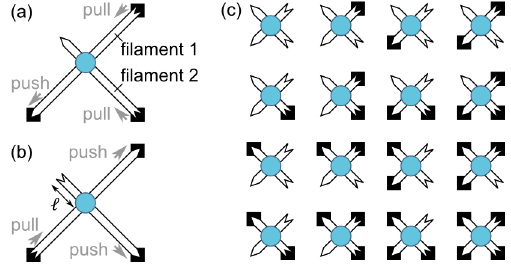
FIG. 2. Contraction induced by a position-dependent stall force. As in Fig. 1 in all other figures, black squares and blue circles represent cross-links and motors, respectively. (a) Motors in the vicinity of a pointed end typically induce an overall contractile (pulling) force dipole as indicated by gray arrows representing the projection of the forces on the direction of the filaments. (b) Motors close to a barbed end have the opposite effect. (c) We characterize the resulting net contractility by averaging over all possible local cross-linking